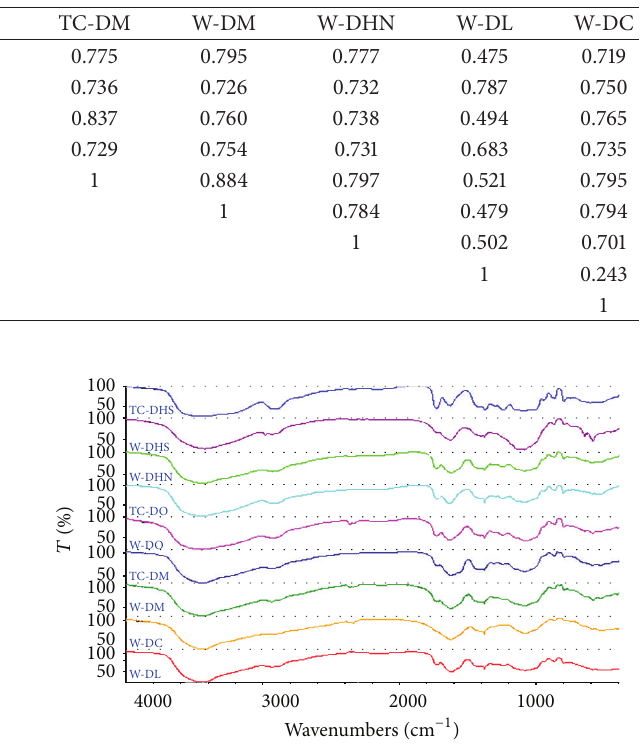
Figure 3: The FTIR spectra of the polysaccharides of seven Dendro- bium samples in the ranges of 4000–400 cm −1